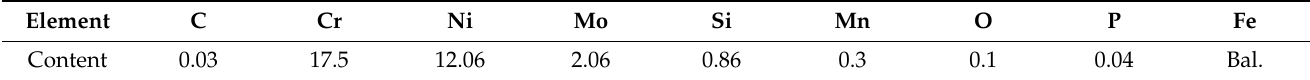
Table 1. Chemical composition of 316L stainless steel spherical powder (mass fraction, %).